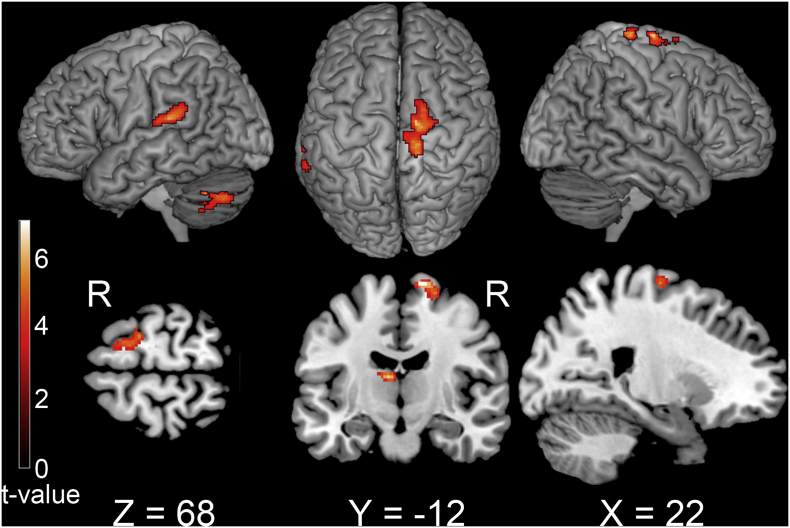
Activation differences during knee movement between an elite long jumper with a below-knee amputation and healthy long jumpers with the take-off leg. For the elite long jumper, the take-off leg had the prosthesis. All take-off legs (right and left) were adjusted to appear as the right leg. The threshold was set at a voxel level of p < .001 (uncorrected), and a cluster level of p < .05 (FWE).